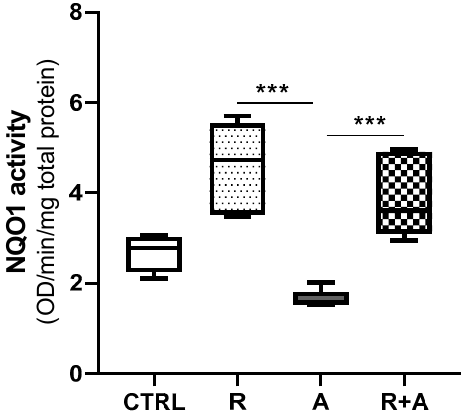
Figure 7. NQO1 enzyme activity. Box and whiskers plot reports the diaphorase activity in different experimental conditions. The statistical comparisons were established between the median NQO1 activity in cells exposed to AFB1 and the median NQO1 activity observed in the other experimental conditions. For each experimental condition, six independent cell culture experiments were per- formed. Data are expressed as median optical density (OD) observed per min per mg of total protein. CTRL condition corresponds to cells exposed to PCB126 only. R = resveratrol; A = AFB1. *** p < 0.001 (one-way ANOVA, followed by Dunnett’s multi-comparisons test).